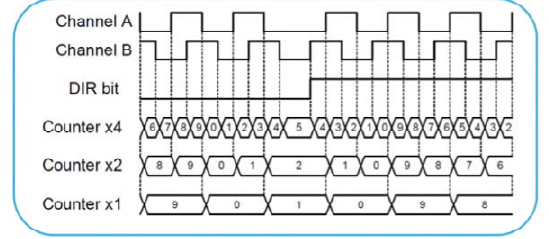
Figure 12. X1 encoding mode added.